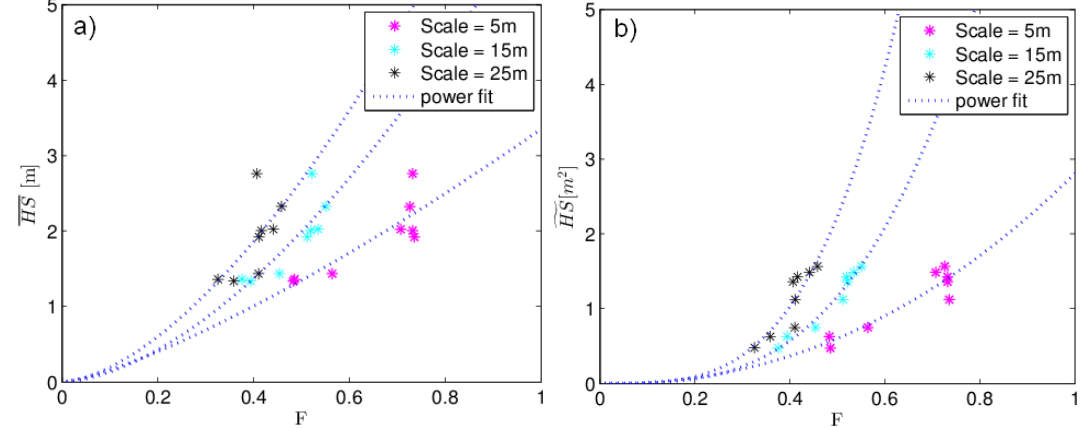
Fig. 9. (a) F as a function of mean snow depth and (b) F as a function of mean snow depth multiplied by its standard deviation for scales of 5, 15 and 25m.